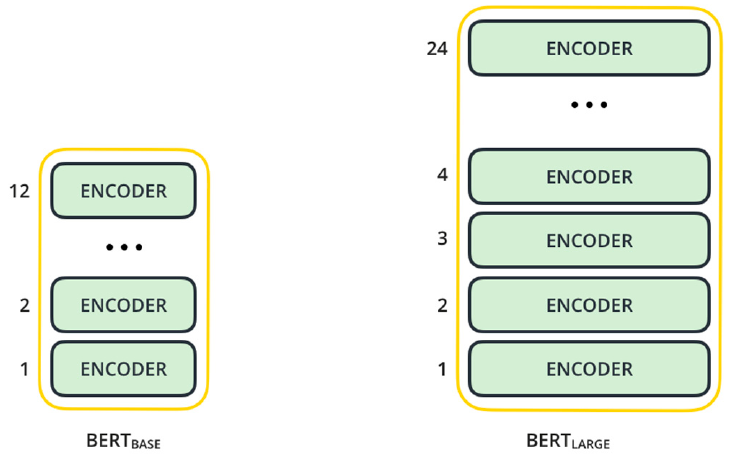
Figure 1. Encoder stacks in both BERT BASE and BERT LARGE [32].